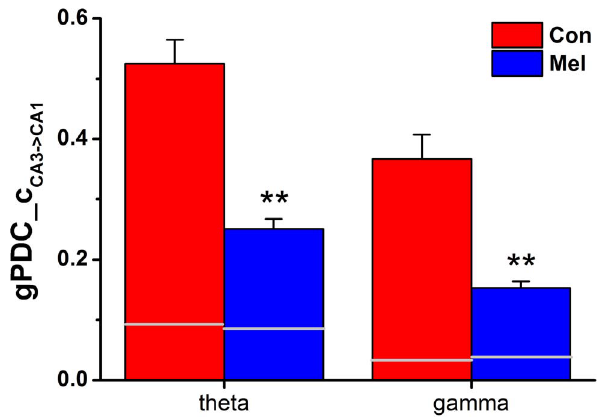
Figure 3. The gPDC analysis in both Con and Mel groups. The comparisons of unidirectional indices C CA3- . CA1 in both theta and gamma rhythms between Con group and Mel group. The gray lines represent unidirectional indices C CA1- . CA3 . Data represent mean 6 SEM. **P , 0.01 for comparison between Con group and Mel group.